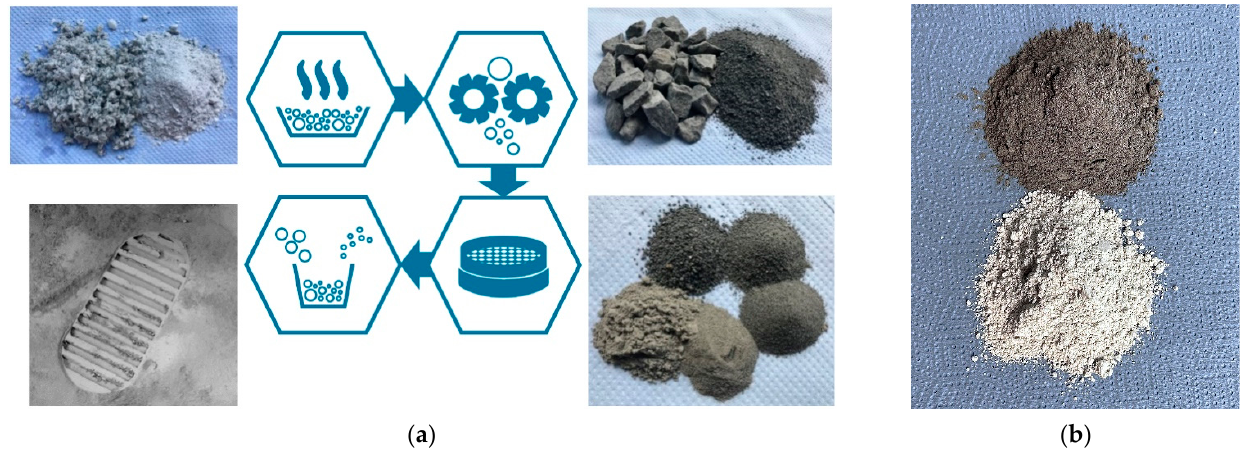
Figure 1. Process chain of regolith simulant production ( a ) and photographs ( b ) of TUBS-M (top) and TUBS-T (bottom) after the final mixing step.